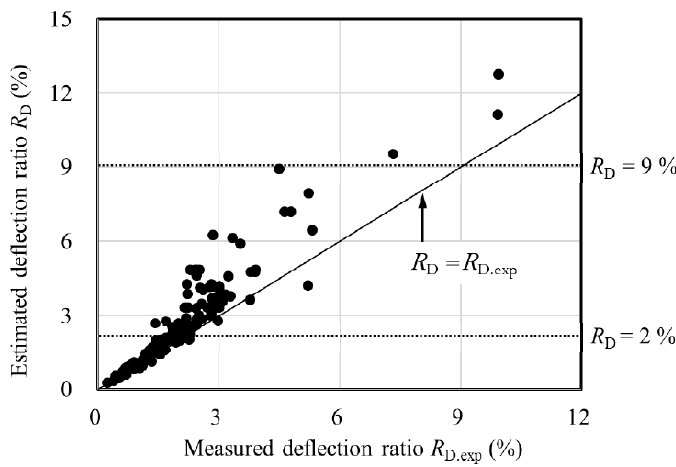
Figure 9. Investigation of the estimation accuracy based on the deflection ratio R D .